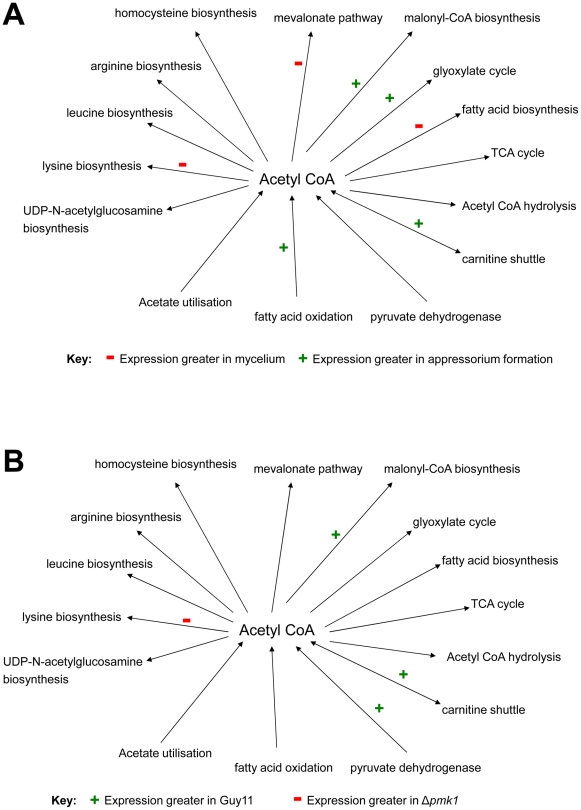
Expression level of genes encoding enzymes that produce or utilise acetyl-CoA.The diagrams illustrate metabolic pathways that produce (arrow pointing towards acetyl-CoA) or utilise (arrow pointing away from acetyl-CoA) acetyl-CoA. Transcript abundance was compared in those genes from each pathway that encode enzymes that directly utilise or produce acetyl-CoA A. Guy11 germinating conidia (4 h) and Guy11 mycelium grown in complete medium. B. Δpmk1 germinating conidia (4 h) and Guy11 germinating conidia (4 h). The diagrams also show which pathways contain genes significantly more highly expressed in one condition as compared to the other (see key for each diagram). These are based on adjusted P-value< = 0.05 for at least one of the genes in each pathway.